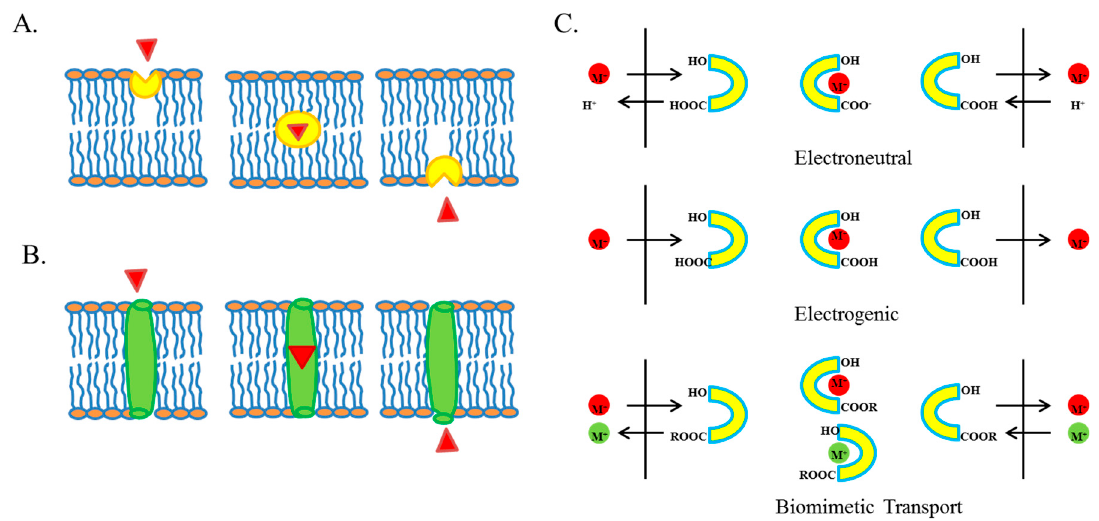
Figure 1. Ionophore mediated ion transport across the membrane. ( A ) Small ionophores “ion carriers” bind with ion, shield it from lipophilic interior of membrane, transport it across the membrane and release it other side of membrane. ( B ) Large ionophores form “ion channels” across the membrane and transport ions through these channels. These channels have a hydrophilic interior which assist in transport of ions while its lipophilic exterior shield ions from repulsive interior of membrane. ( C ) Polyether ionophores carry ions across membrane by electroneutral, electrogenic and biomimetic methods based on the microenvironmental conditions and structure of ionophore. Panel C was modified from [71].